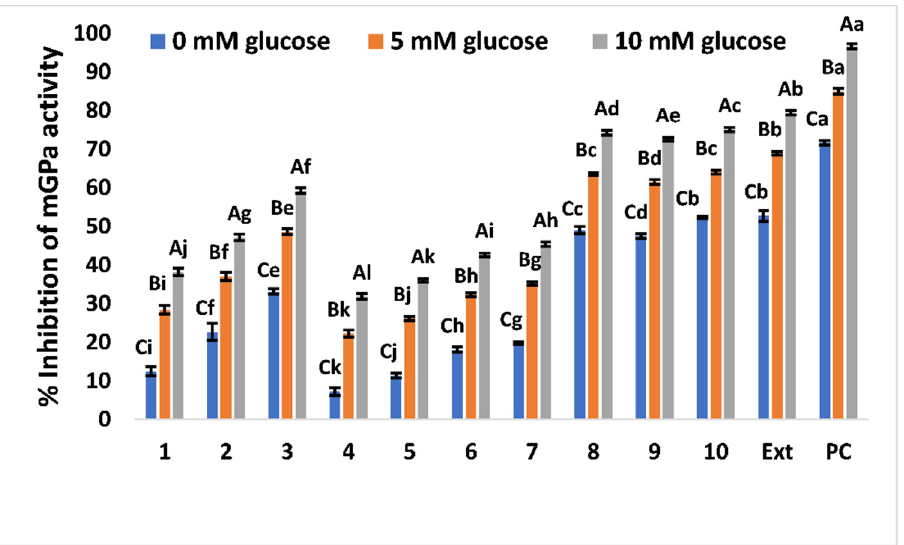
Figure 6. Effect of G . abyssinica extract (Ext) and isolated bioactive compounds on the glycogen phosphorylase activity. The activity of phosphorylated glycogen phosphorylase from rabbit muscle (mGPa) was measured, and CP-91149 was used as a positive control (PC). Lowercase letters indicate significant differences in mGPa activity among treatment conditions ( p < 0.05). Upper-case letters indicate significant differences in mGPa activity among glucose concentrations ( p < 0.05). Data are presented as the means ± standard deviations.